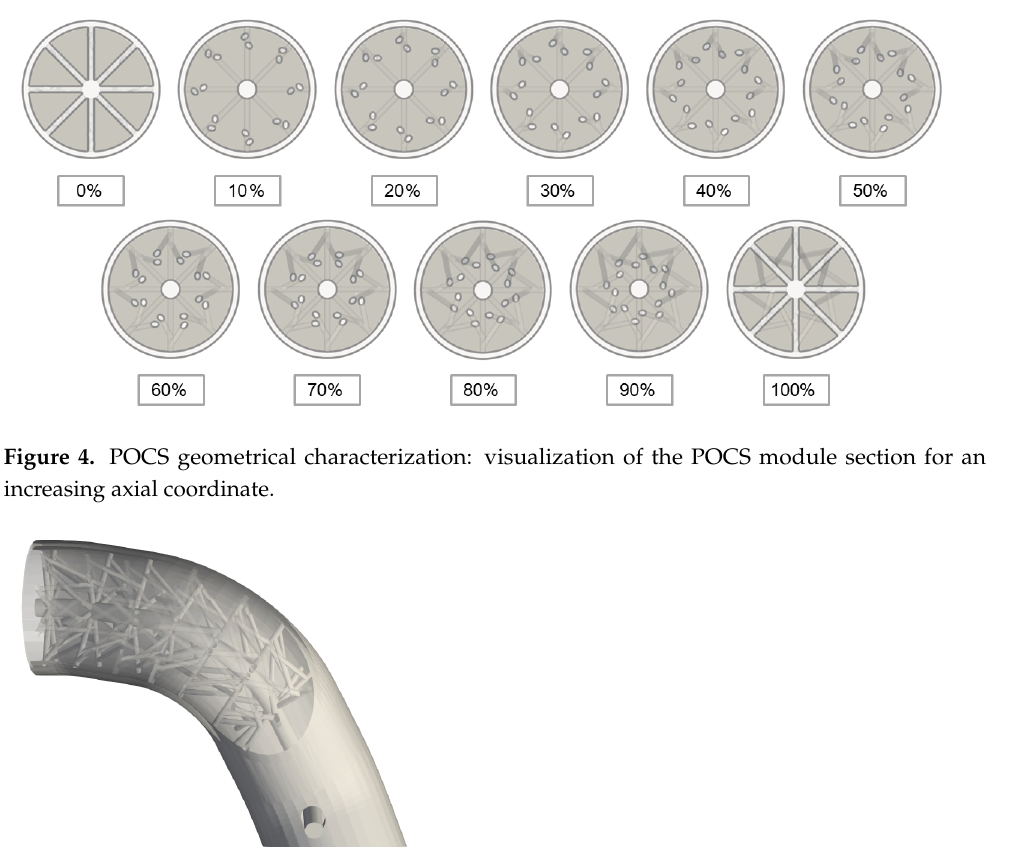
Figure 5. POCS geometrical characterization: Curved configuration—fitting inside an exhaust manifold.